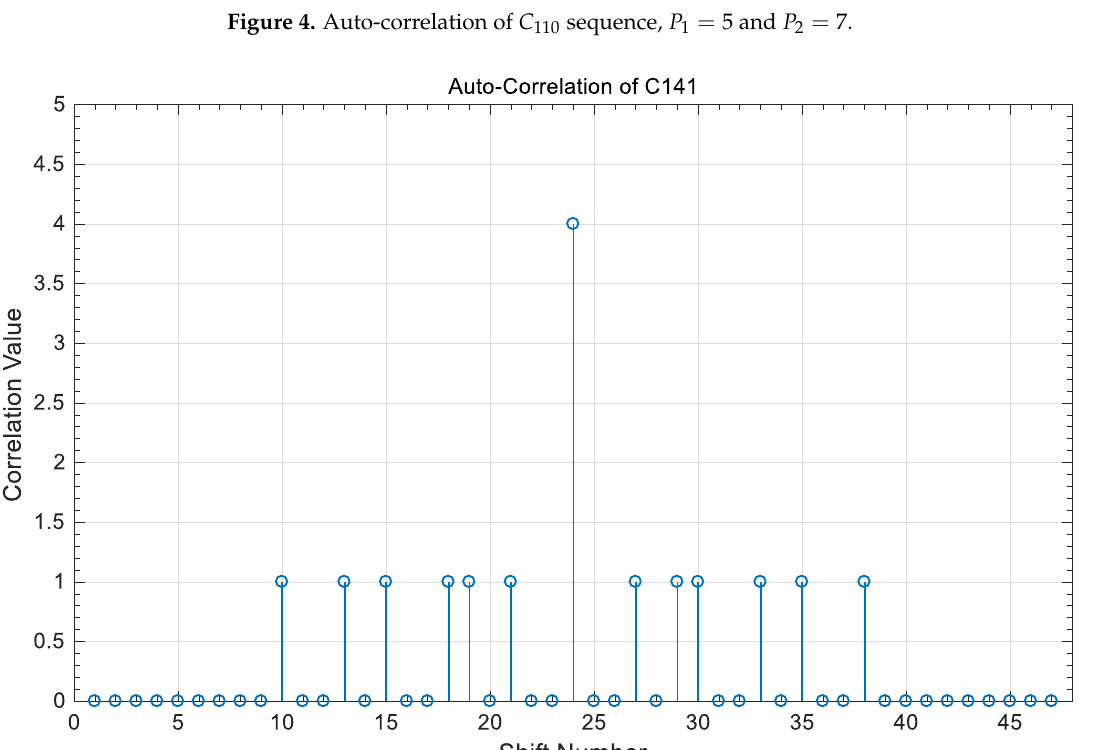
= 5 and P = 2 141 sequence, P 1